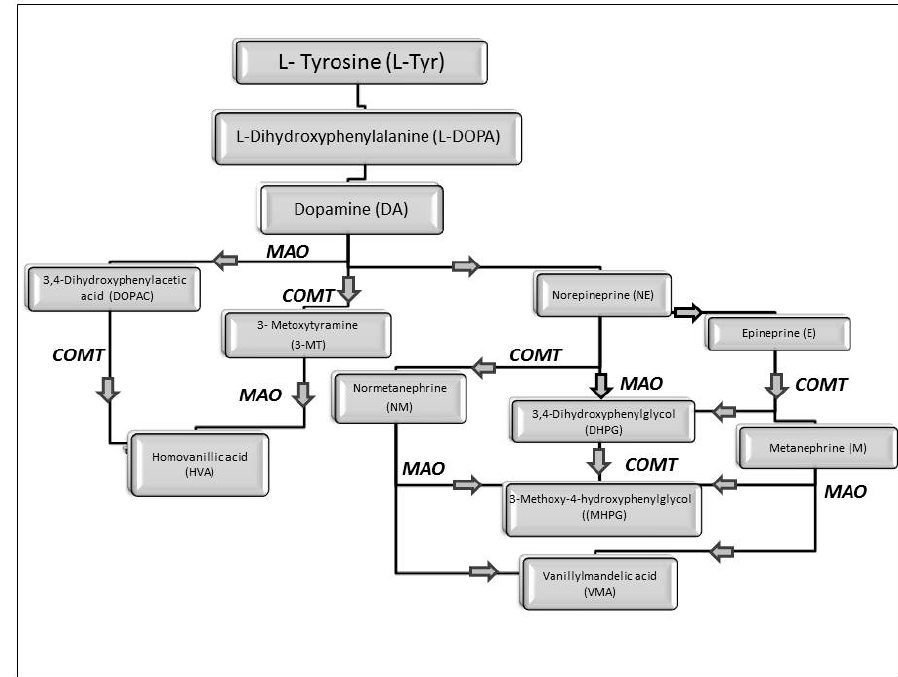
Figure 2. The main products of the L-Tyr metabolic pathway.